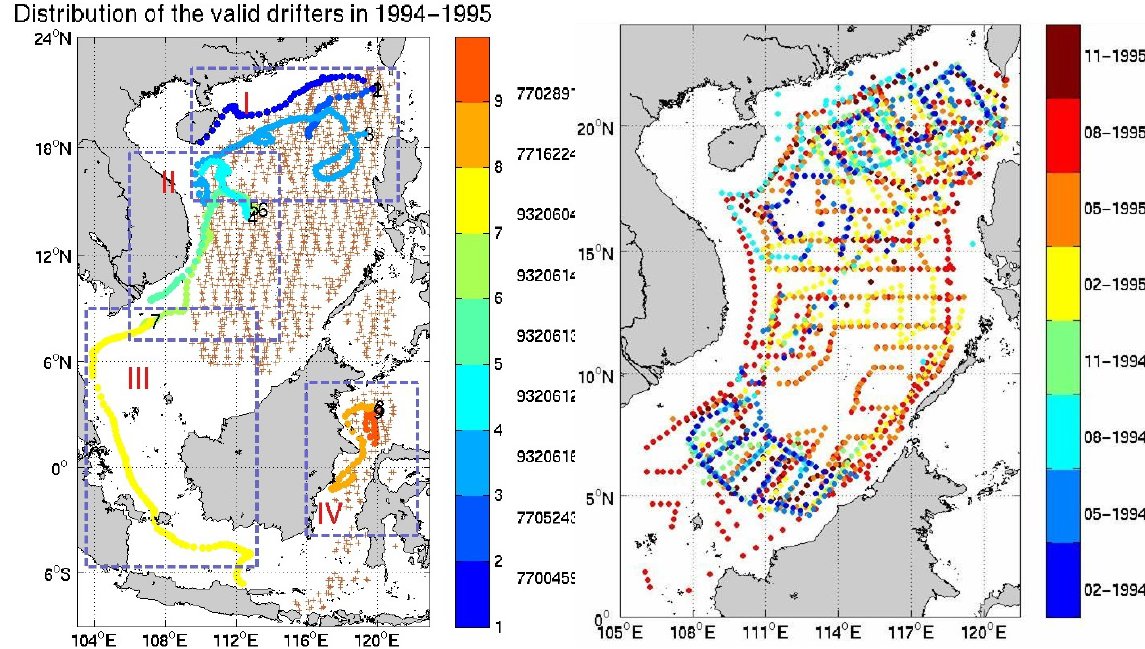
Fig. 3. Left: trajectories of the 9 surface drifters collected from January 1994 to December 1995. Geographically, these drifters are divided into 4 groups: in the Northern SCS (I), in the east of Vietnam (II), in the Sunda shelf (III), and near the Makassar Strait (IV), as denoted by the blue dashed rectangles. The crosses denote the assimilated observations from ERS-2 and TOPEX west of 121 ◦ E during this period. Right: locations of the observed profiles from EN3 used in